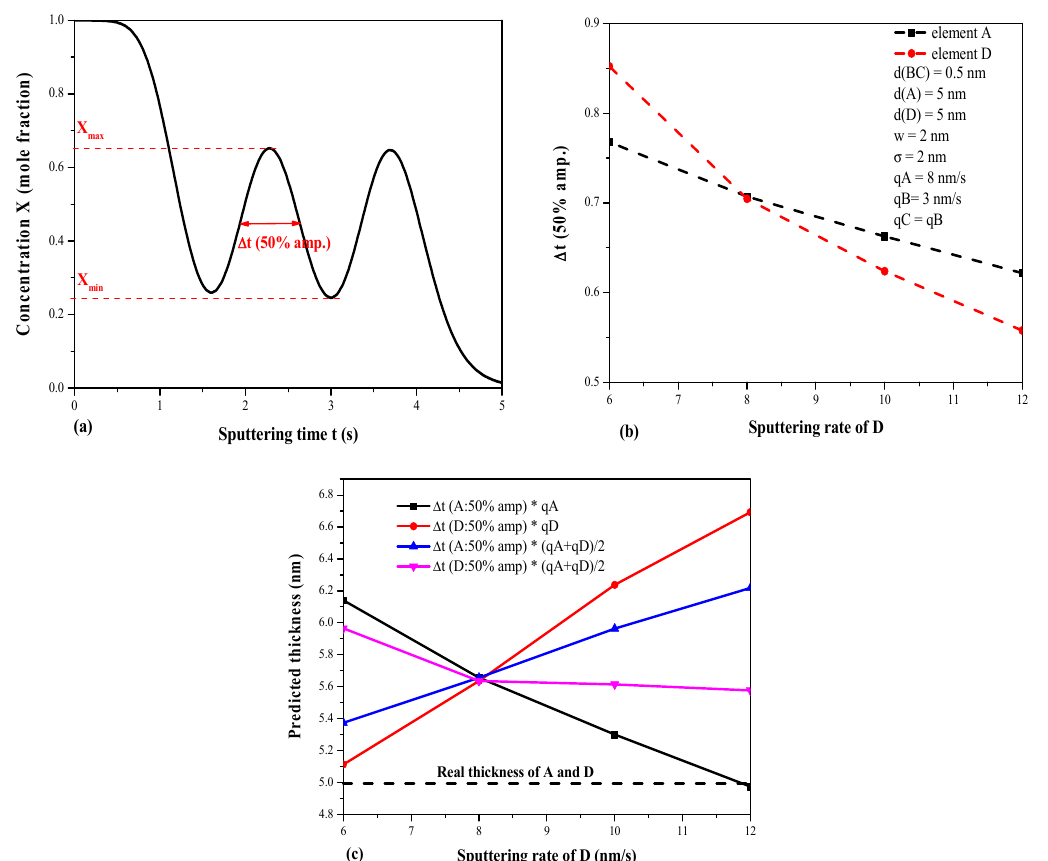
Figure 4. ( a ) Sketch of the FWHM in the measured time-concentration profile of each layer. ( b ) FWHM values of elements A and D as a function of the sputtering rate of element D. ( c ) Thickness determined by the product of the corresponding FWHM and the (average) sputtering rate of element A and D.